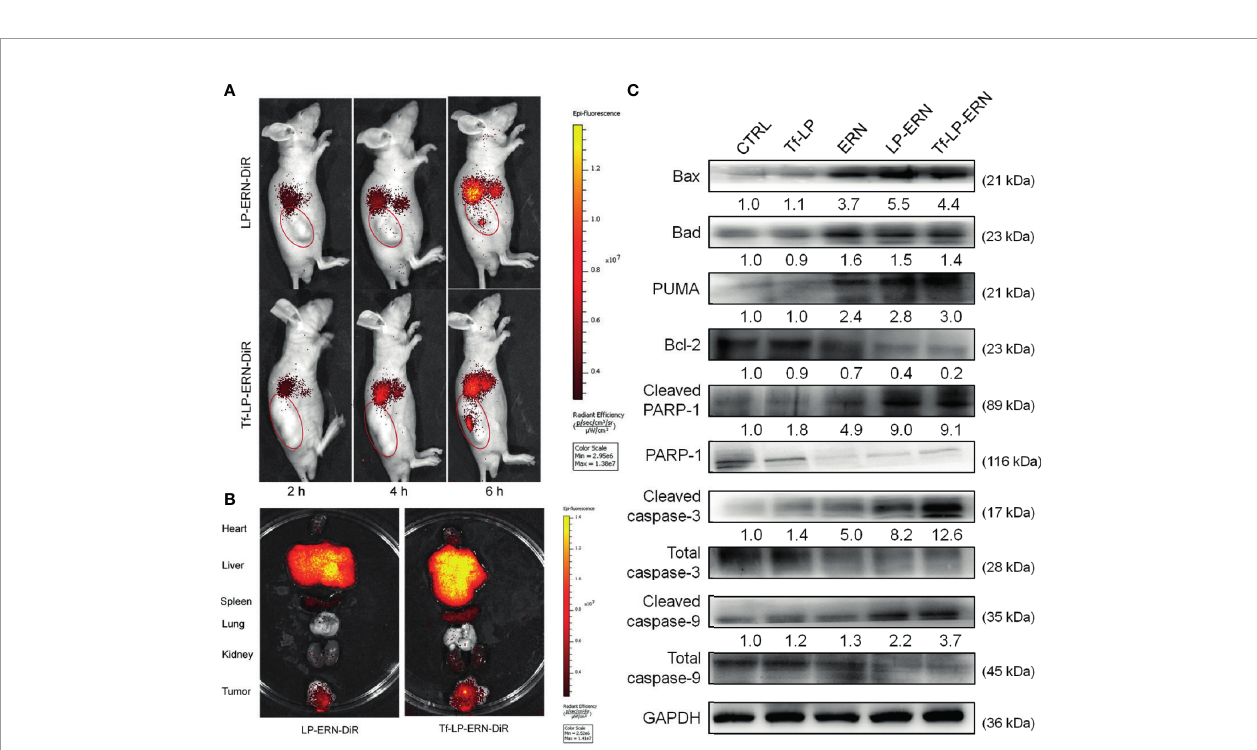
FIGURE 4 | Tf-LP-ERN alleviated cancer development by targeting tumor tissues and caused mitochondrial apoptosis. (A) LP-ERN and Tf-LP-ERN labelled by DiR gradually accumulate to tumor tissues in SMMC-7721-xenotransplanted BALB/c nude mice (n = 3/group). (B) The tissue distribution of LP-ERN and Tf-LP-ERN in heart, liver, spleen, lung, kidney and tumor after 6 h of tail vein injection in SMMC-7721-xenotransplanted BALB/c nude mice (n = 3/group). (C) ERN, LP-ERN and Tf-LP-ERN regulated the expressions of Bcl-2 family members and caspases in tumor tissues of SMMC-7721-xenotransplanted BALB/c nude mice. Quanti fi cation data were normalized by GAPDH or the corresponding total proteins and were reported as the folds of those from the corresponding CTRL mice (n = 3).